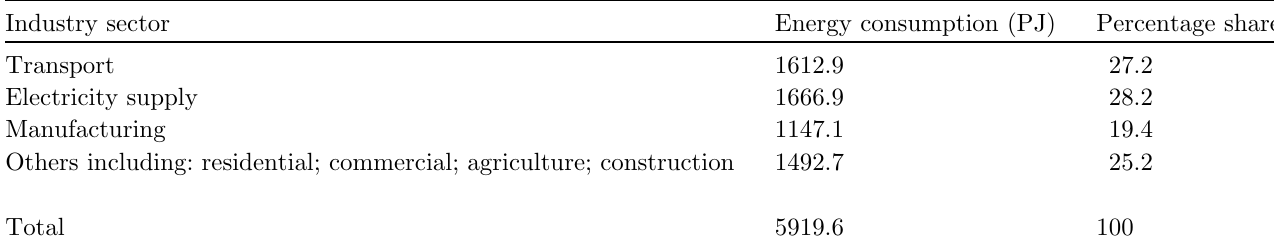
Table 1. Australian energy consumption by industry in 2014 –